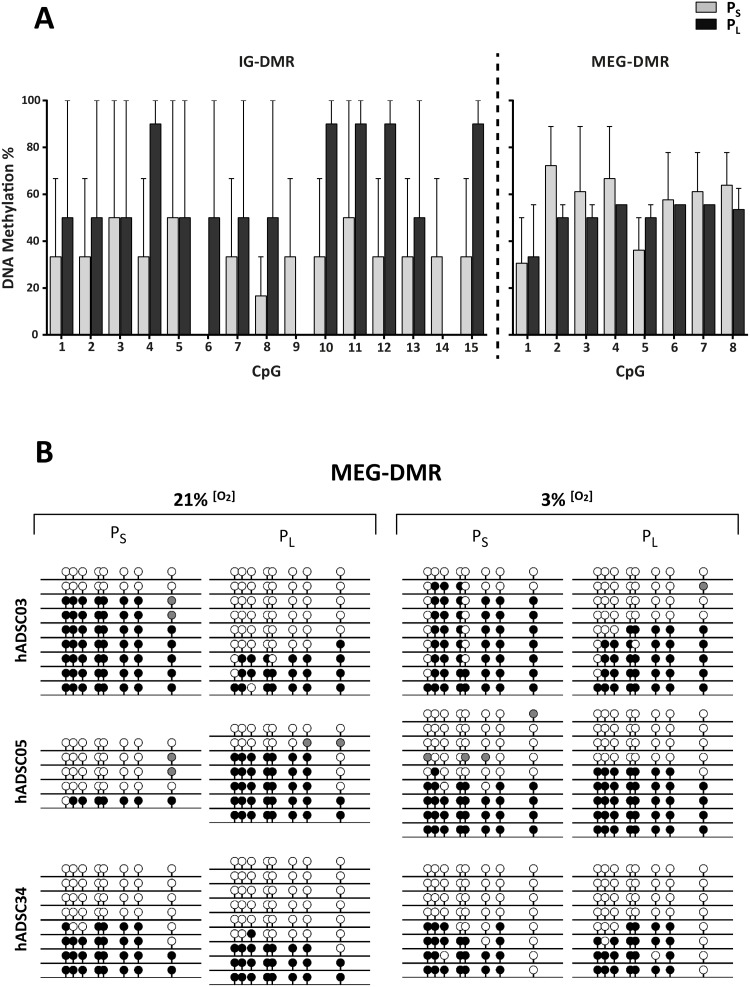
DNA methylation analysis of DLK1-DIO3 IG- and MEG-DMR regions.(A) Percentage of DNA methylation in hADSC samples; x-axes indicate the CpG analyzed in the IG-DMR (1–15) and in the MEG-DMR region (1–8). Data represent mean ± SEM for PS and PL cultures. (B) Bisulfite genomic sequencing of the MEG-DMR regions. CpG dinucleotides are represented as lollipops; methylated cytosines, black; unmethylated cytosines, white. Cultures grown at 21% or 3% [O2] (PS
vs. PL) were compared for the indicated hADSC samples.